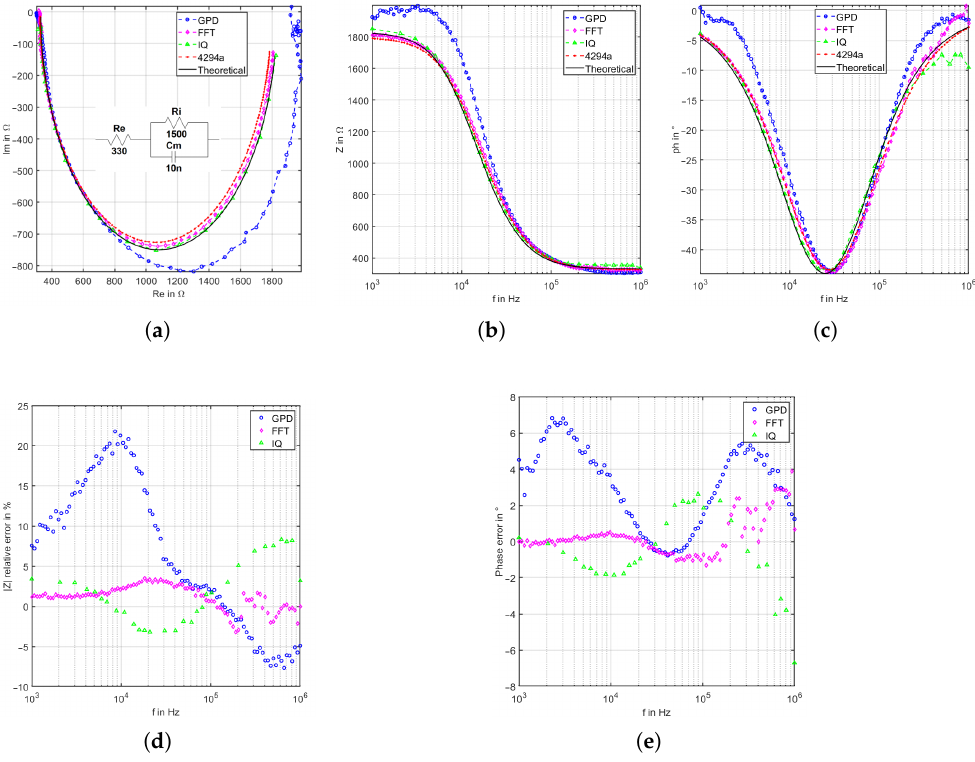
Figure 10. Evaluation of Cole–Cole model 1 using 330 Ω resistor in series to parallel 1.5 k Ω and 10 nF. ( a ) Nyquist plot, ( b ) magnitude bode plot, ( c ) phase bode plot, ( d ) magnitude relative deviation, and ( e ) phase relative